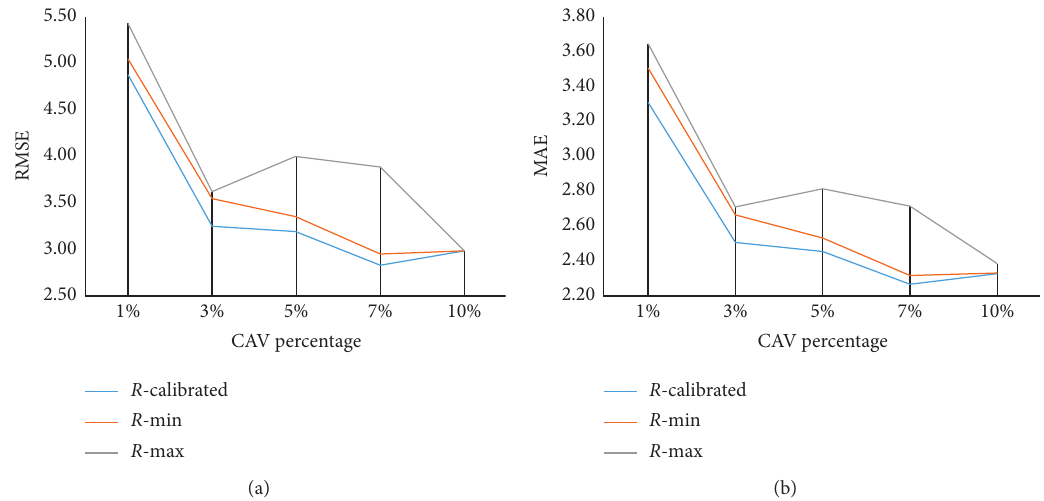
Figure 10: The impact of measurement error ( R ) on accuracy. (a) Impact on RMSE. (b) Impact on MAE.